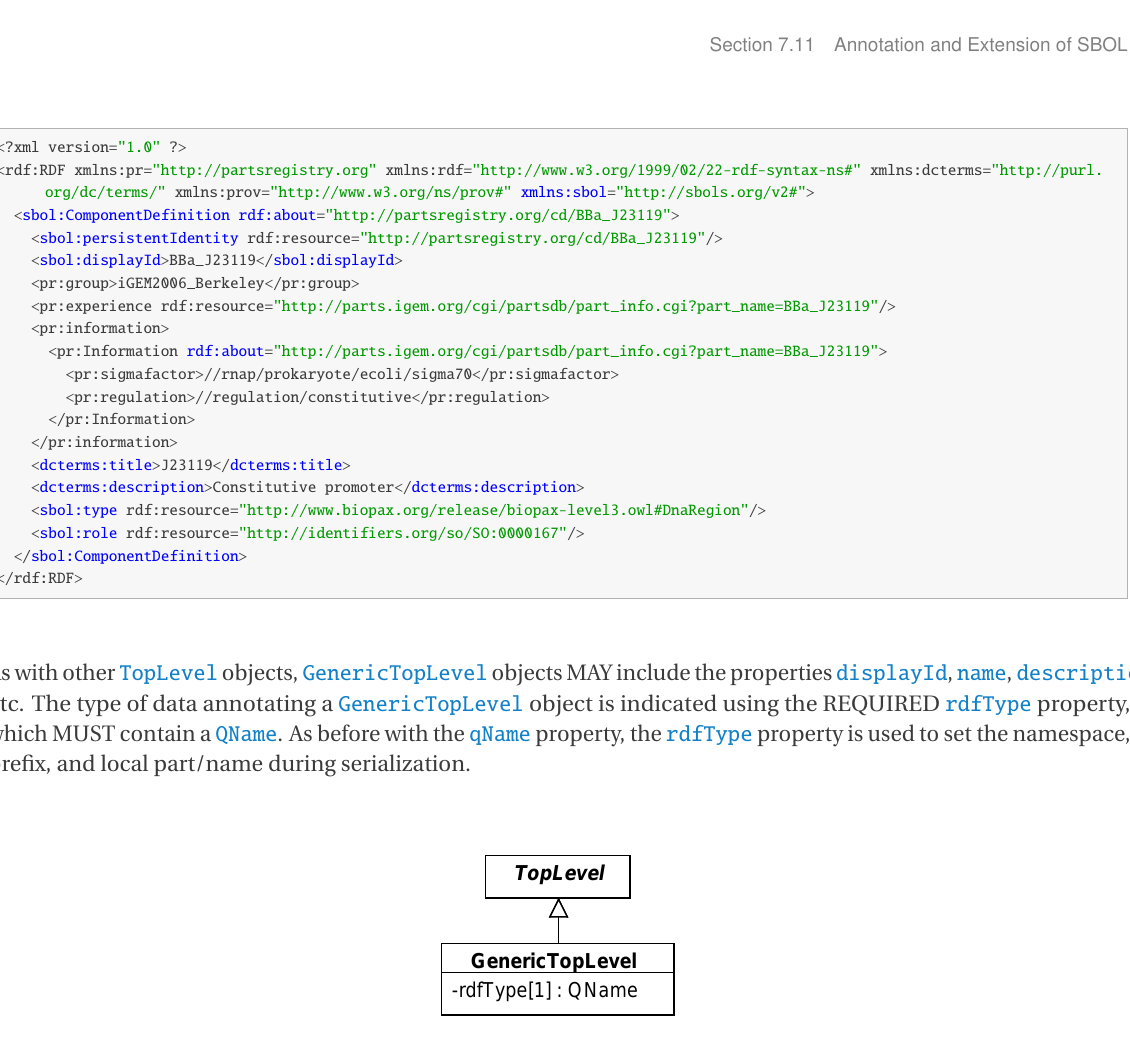
Figure 21: Diagram of the GenericTopLevel class and its associated properties, which is used for embedding externally defined entities into SBOL documents.